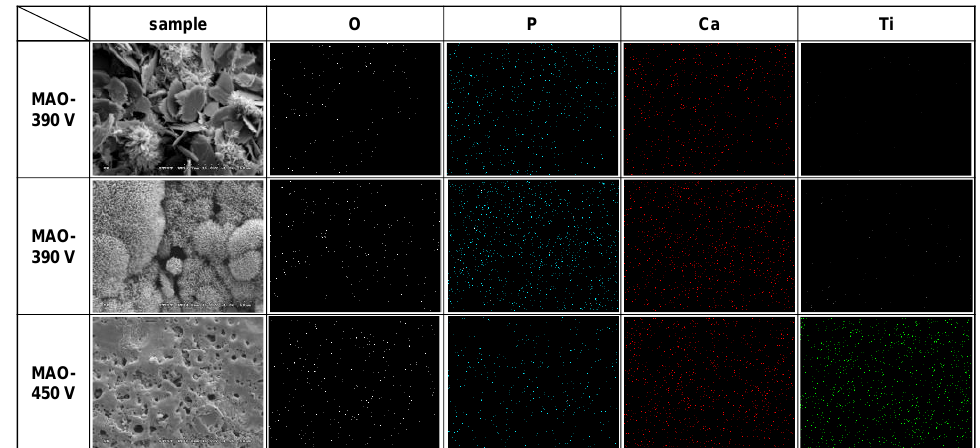
Figure 8. EDS elemental mappings and corresponding SEM images (applied current: 0.6 A, duration time: 5 min).